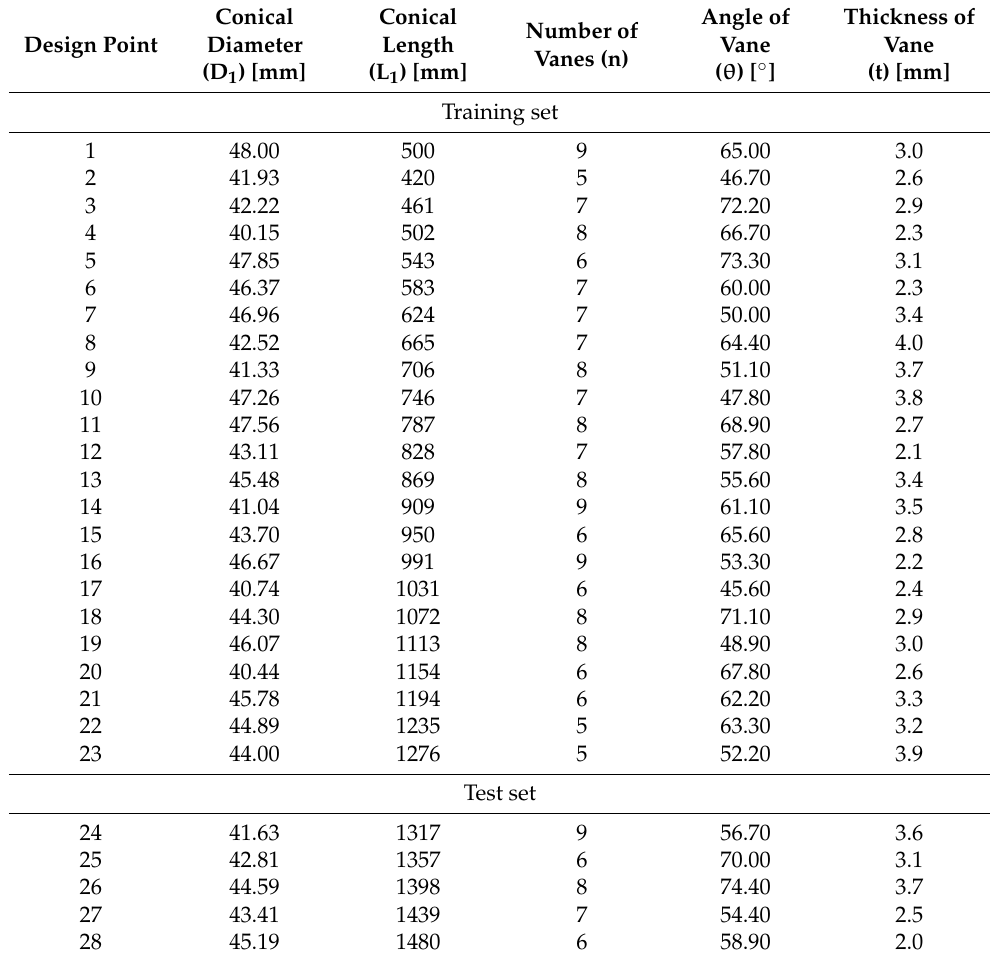
Table 2. Design points of